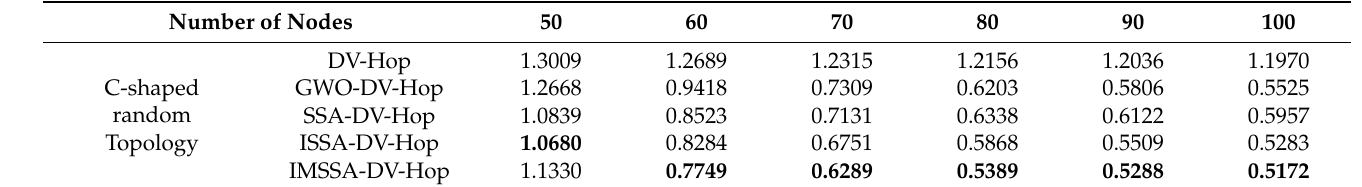
Table 5. Localization error in di ff erent number of nodes in C-shaped random topology.